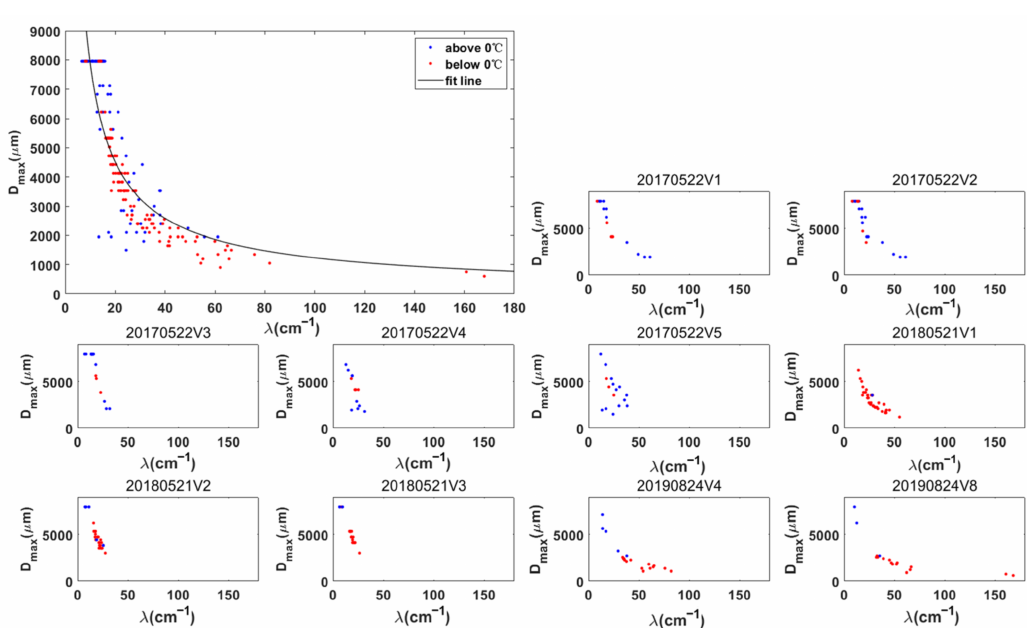
Figure 18. The relationship of N 0 and λ